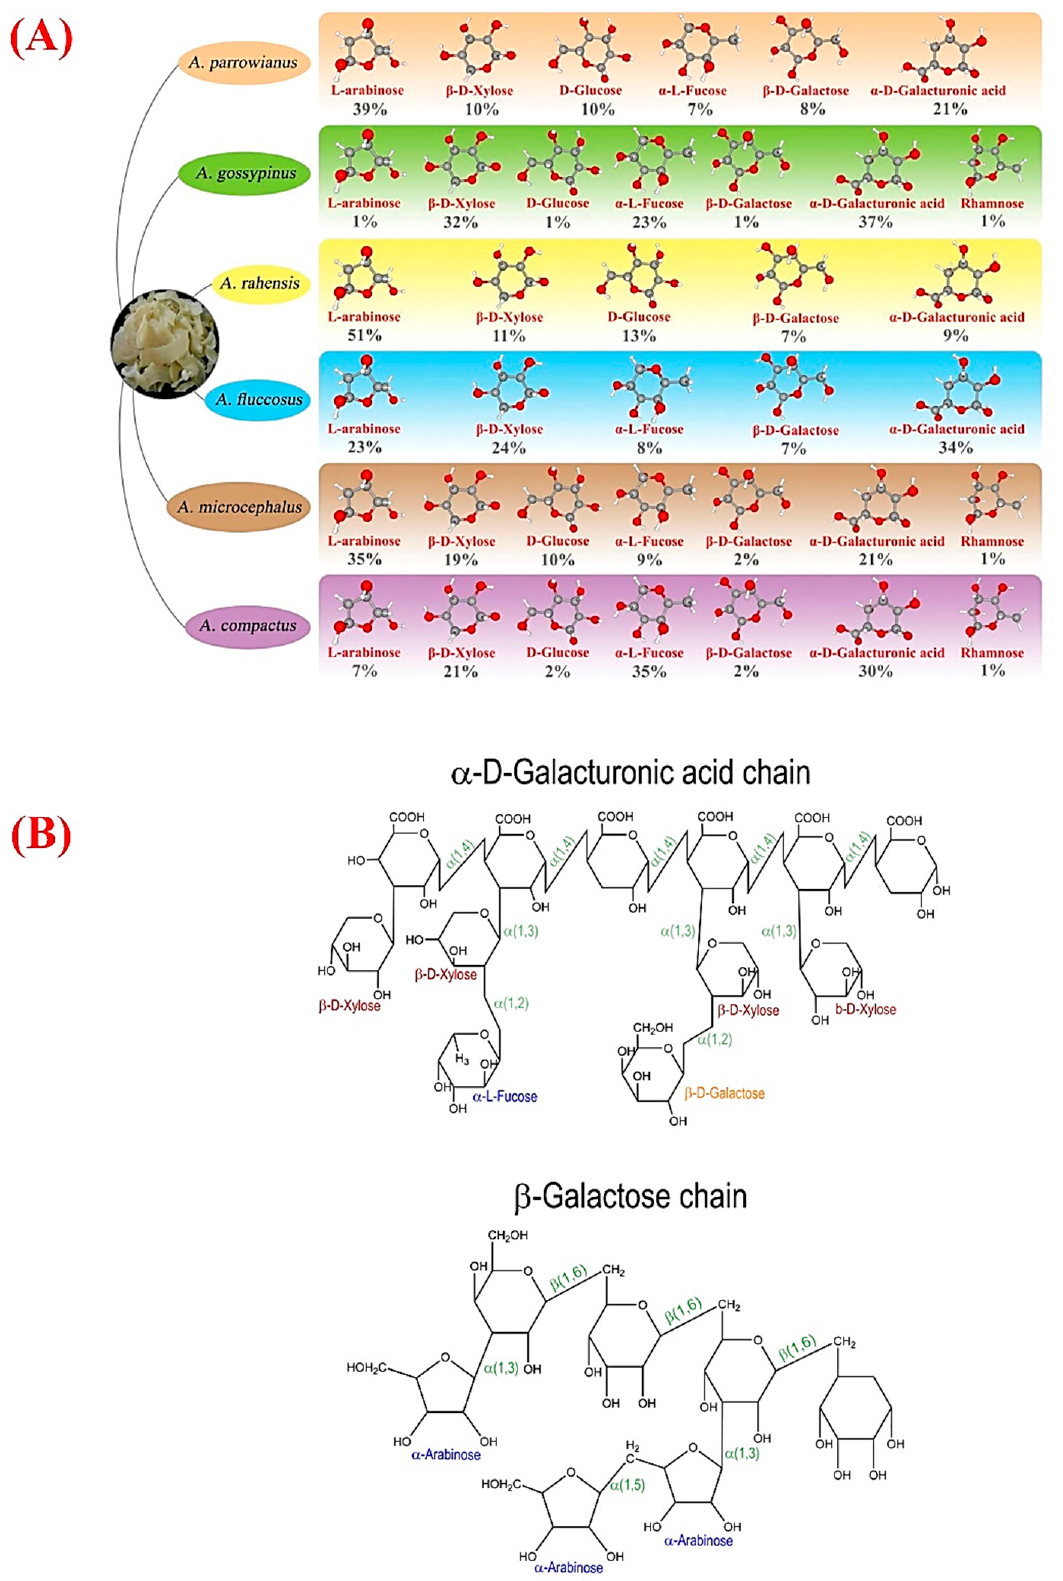
Figure 2. ( A ) Comparison of major chemical components of different GT species. ( B ) Proposed chemical structure of GT, including xylogalacturonan (top) and arabinogalactan (down). With permission from [23] Copyright 2020, Elsevier.